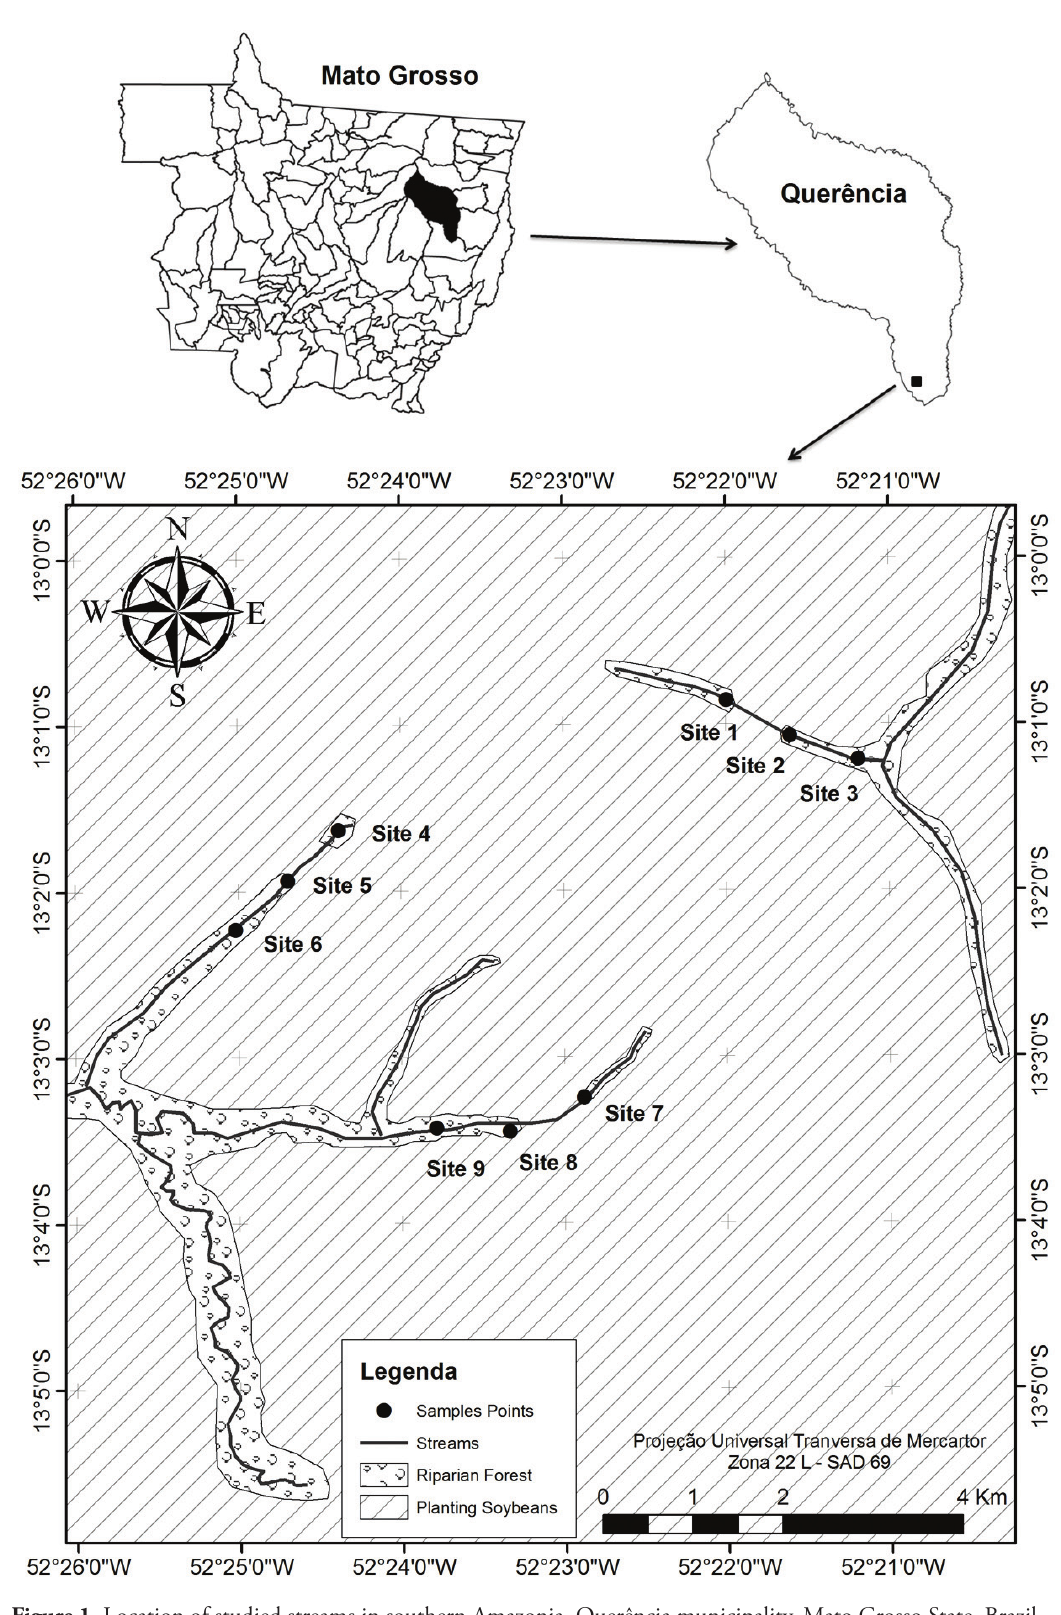
Figure 1. Location of studied streams in southern Amazonia, Querência municipality, Mato Grosso State,